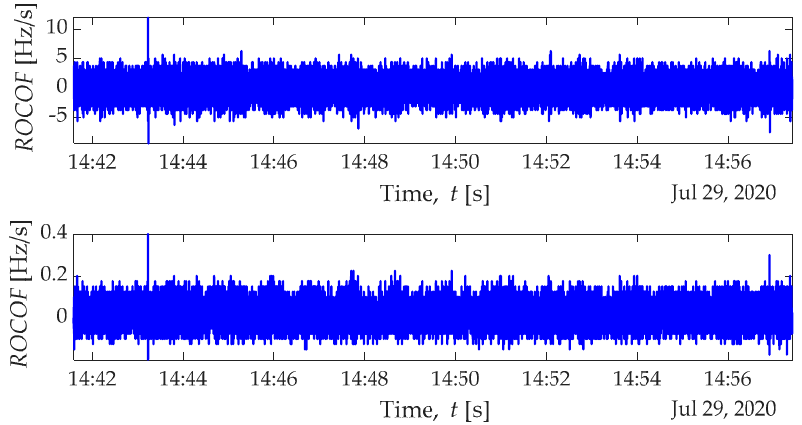
Figure 19. Time series of the moving window-based calculation of the RoCoF , ( top ) moving window size of 0.04 s and ( bottom ) 500 ms.